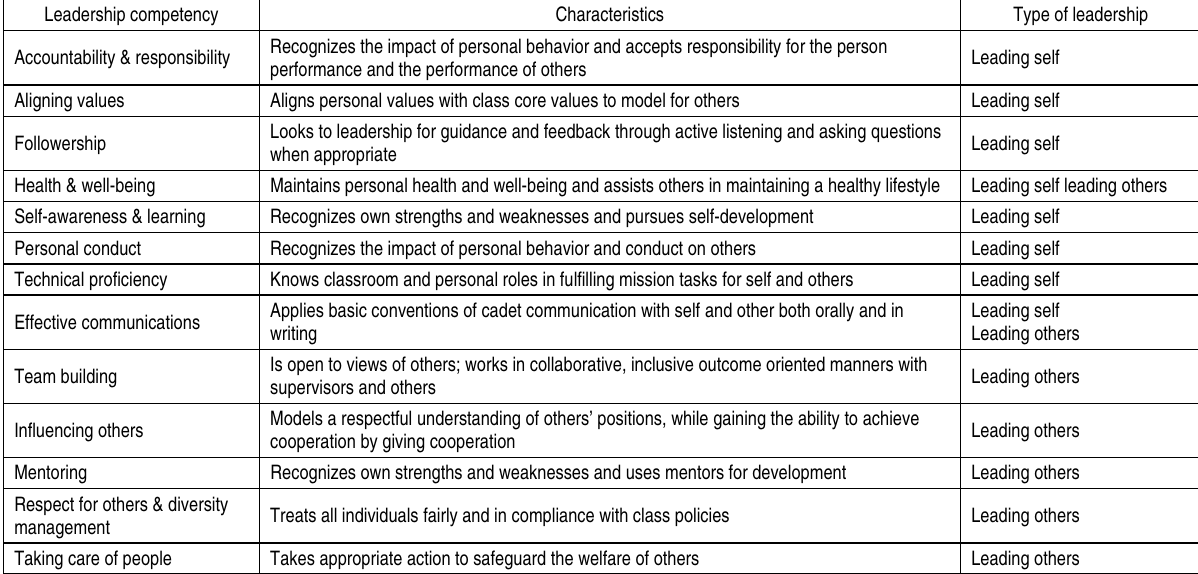
Table 1. Leading self and leading others leadership